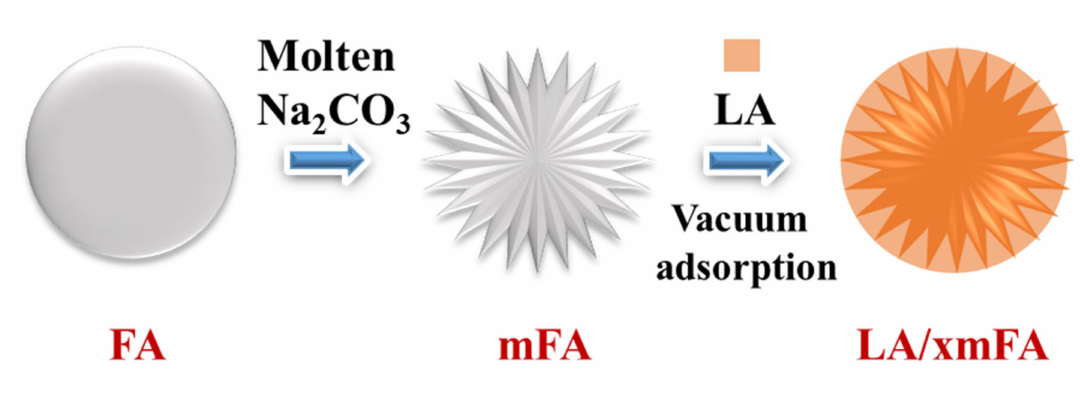
Figure 2. Schematic illustration of the composite preparation. Figure 3 revealed the micromorphology of FA, 0.2 mFA, 0.4 mFA, and their